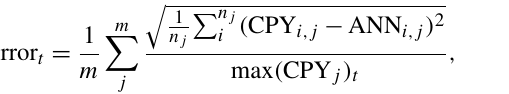
Figure A1. The evolution of the fraction of E. coli relative to the to- tal cell density ( E. coli + S. enterica ) over 100h. Dashed and dotted lines denote an initial abundance of 99 and 1% E. coli , respectively.